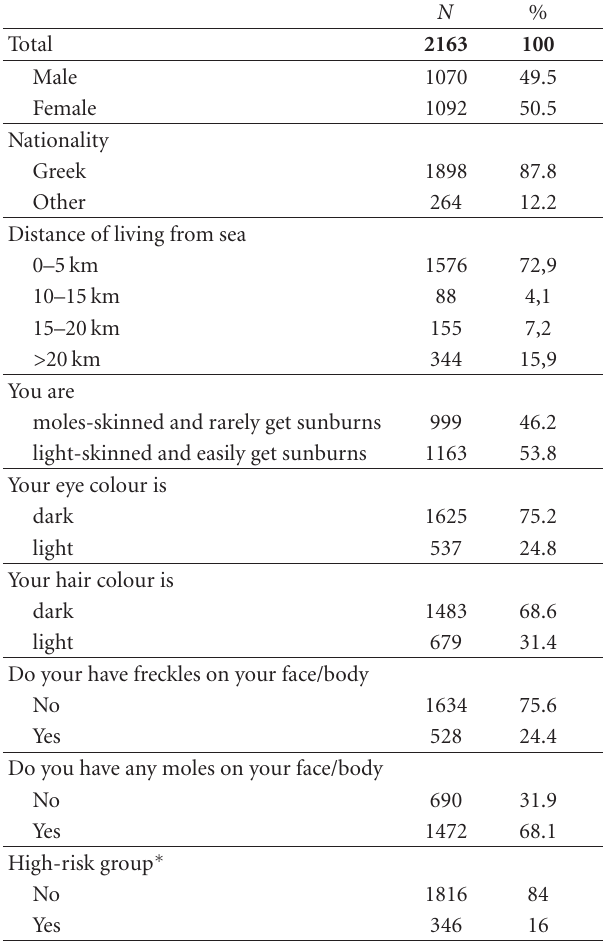
Table 1: Individual characteristics of the students.